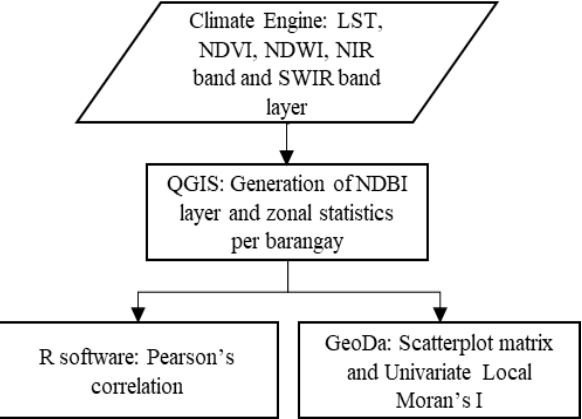
Figure 2. Workflow for investigating relationship among LST and land cover distribution